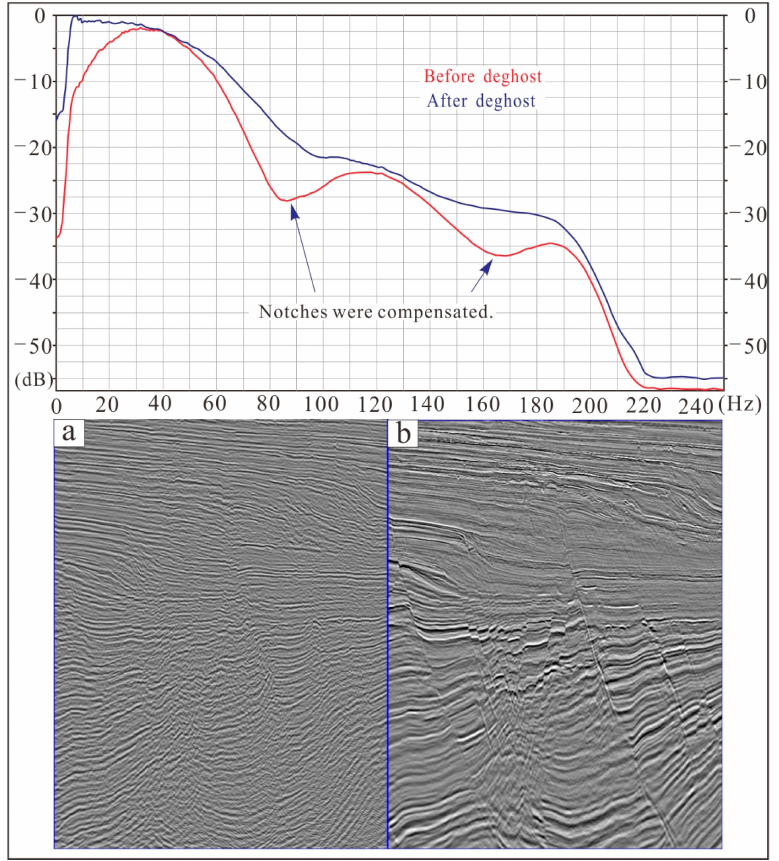
Figure 7. Spectral analysis and gathers before ( a ) and after ( b ) ghost wave